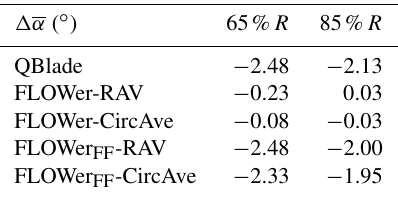
Table 10. Differences between the experiment and the different simulation results of the angle of attack for CaseBASE.